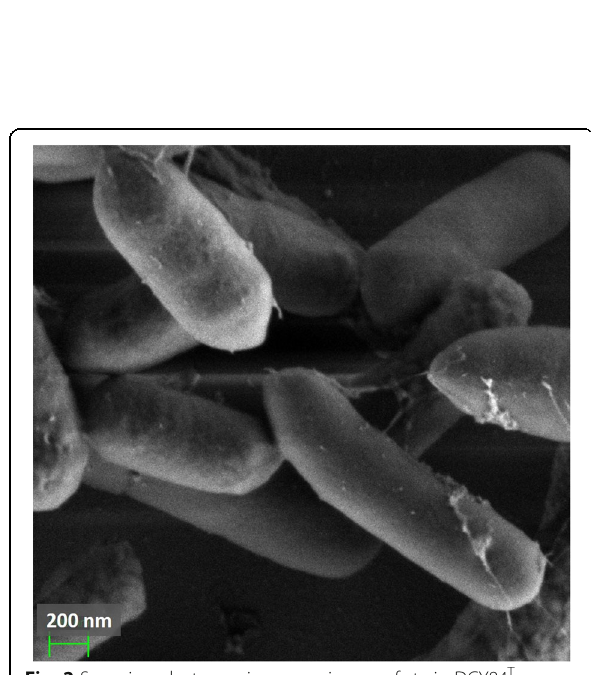
Fig. 2 Scanning electron microscopy image of strain DCY84 T